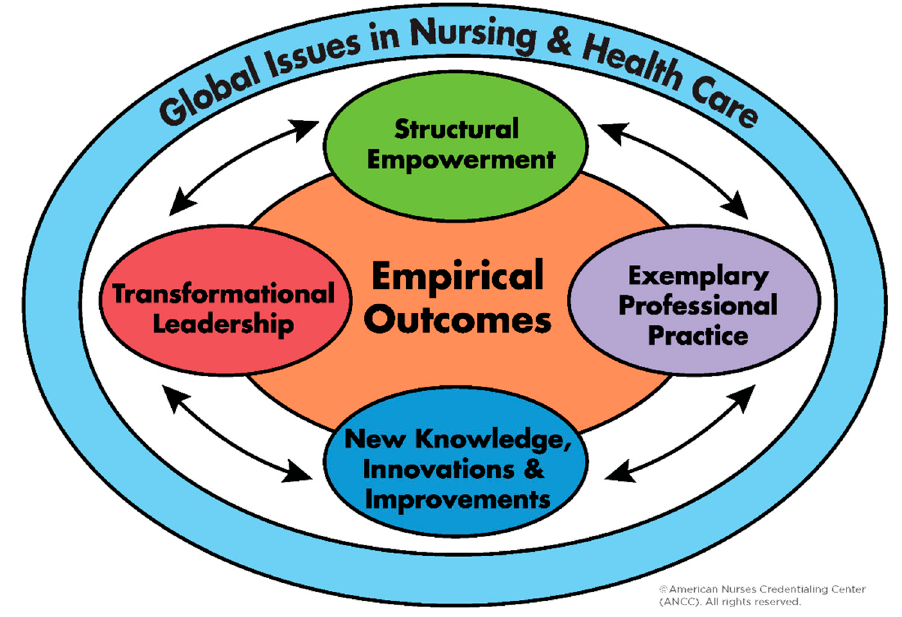
Figure 1. The Magnet ® framework.